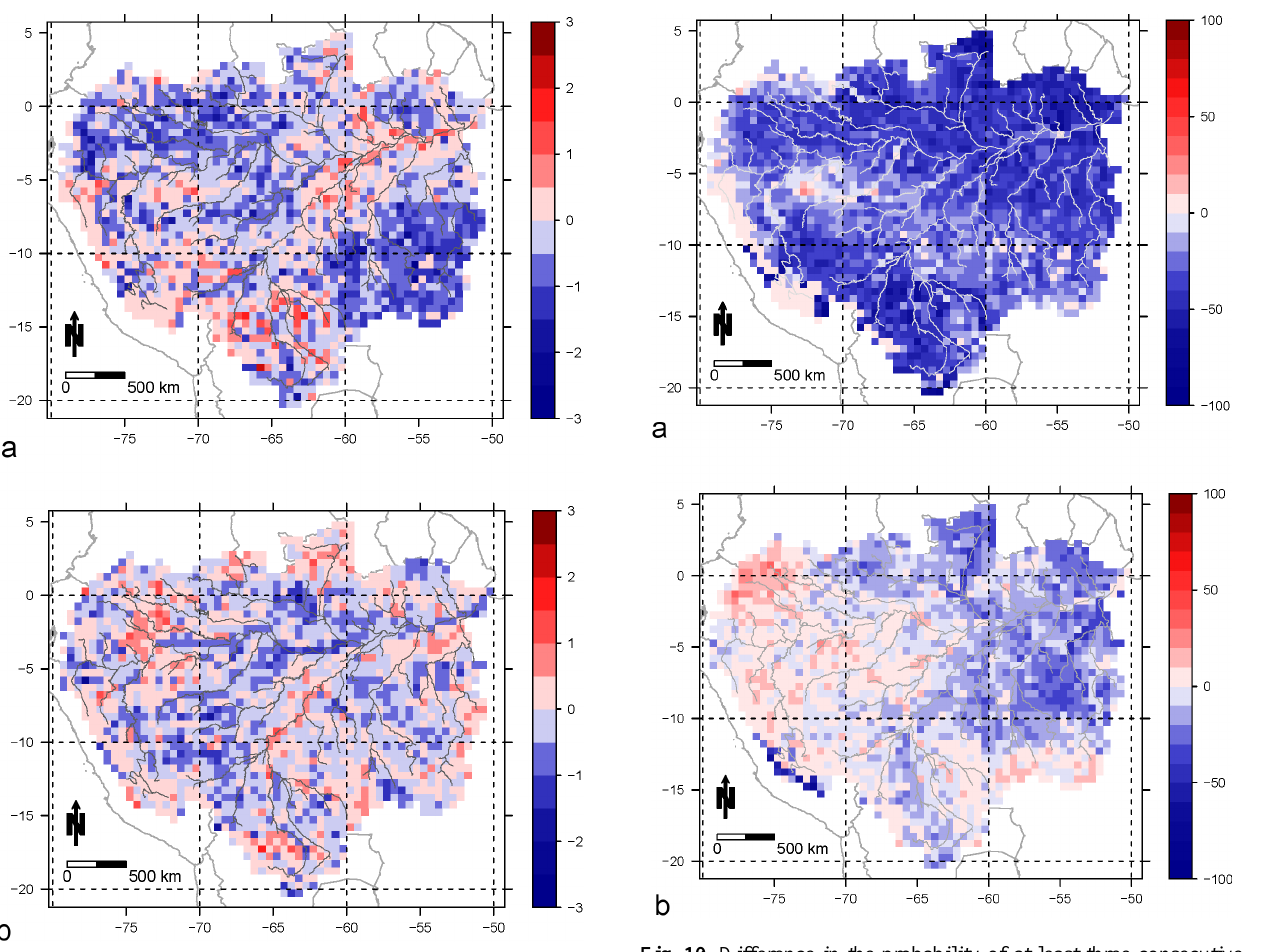
Fig. 9. Difference of the number of (a) extremely dry years and Figure 9. Difference of the number of (a) extremely dry years and (b) extremely wet 858 (b) extremely wet years between future and reference period. years between future and reference period. 859